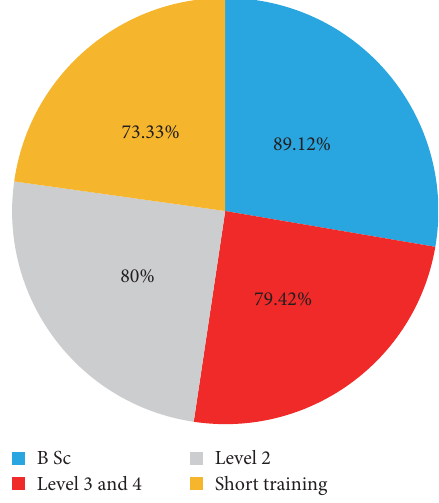
F IGURE 5: Total competency of DAs by their education